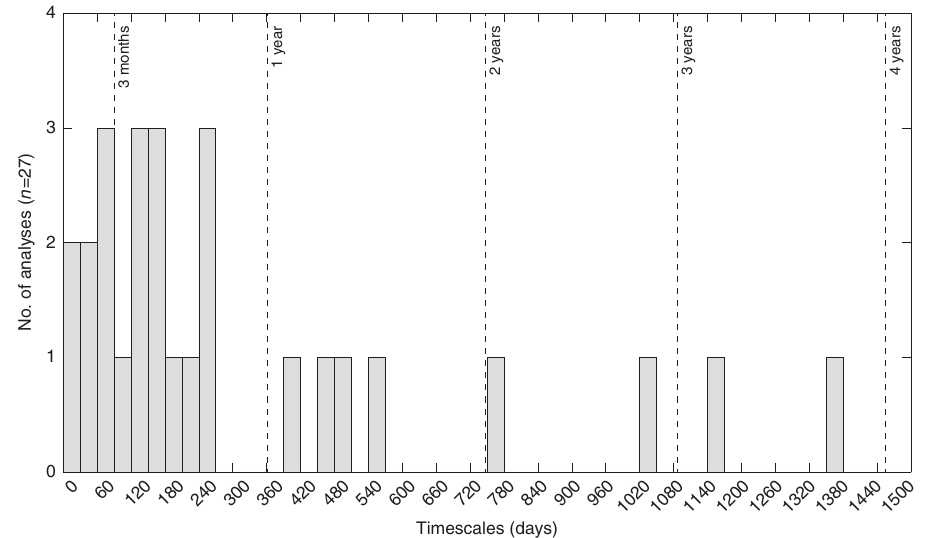
Fig. 4 Histogram showing the distribution of timescales obtained from Fo. Note that about 70% of times are less than 9 months, and that there is no discernible mode, implying progressive magma additions rather than a single large